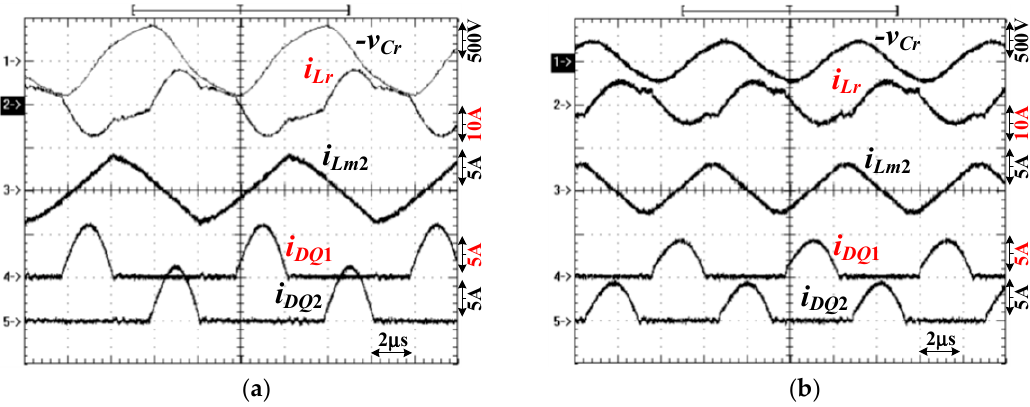
Figure 11. Test results of − v Cr , i Lr , i Lm 2 , i DQ 1 , and i DQ 2 under reverse power flow and 480 W output with ( a ) V 2 = 38 V and ( b ) V 2 = 52 V.